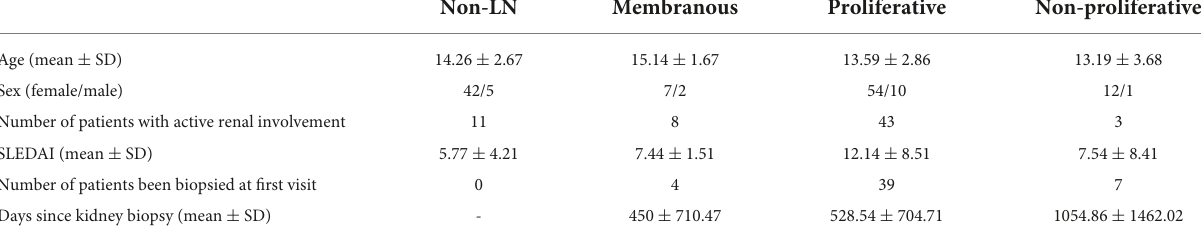
TABLE 2 Detailed clinical information of GSE65391.